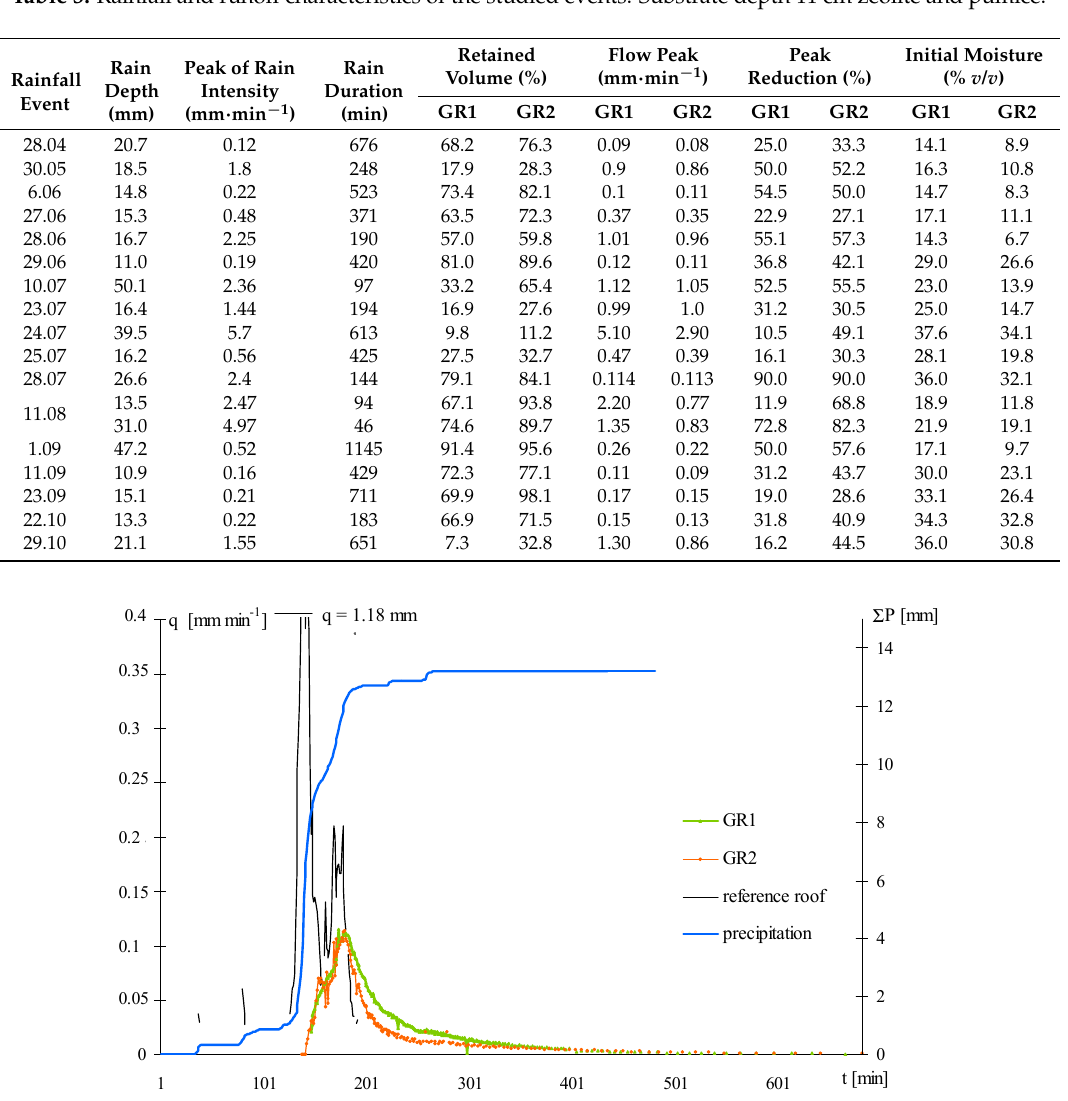
Table 3. Rainfall and runoff characteristics of the studied events. Substrate depth 11 cm zeolite and pumice.